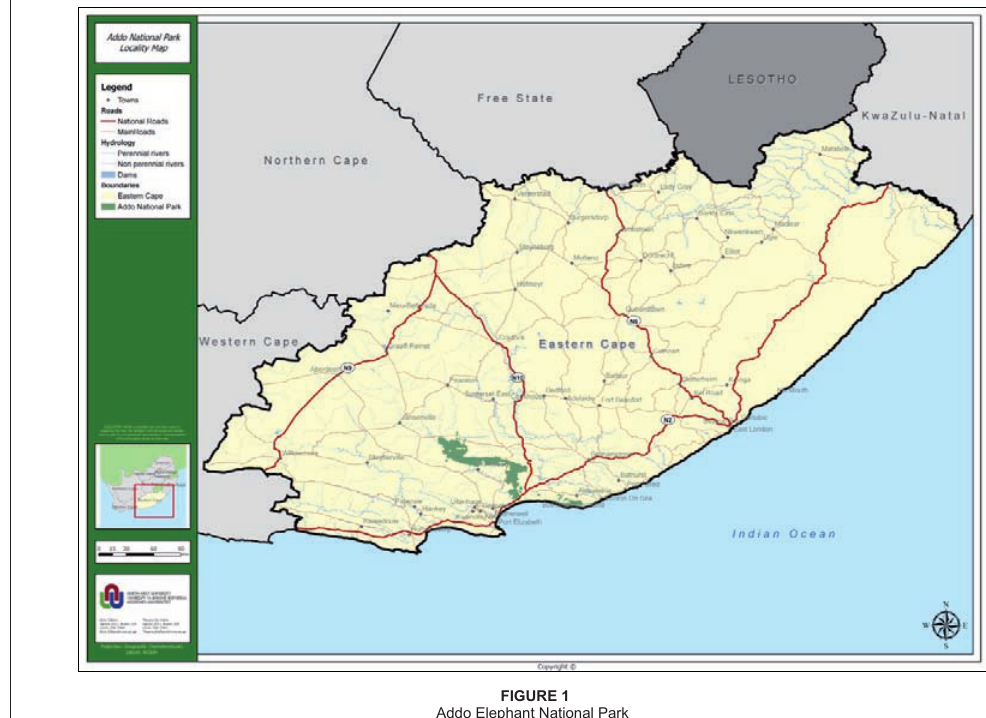
Figure 1 Addo Elephant National